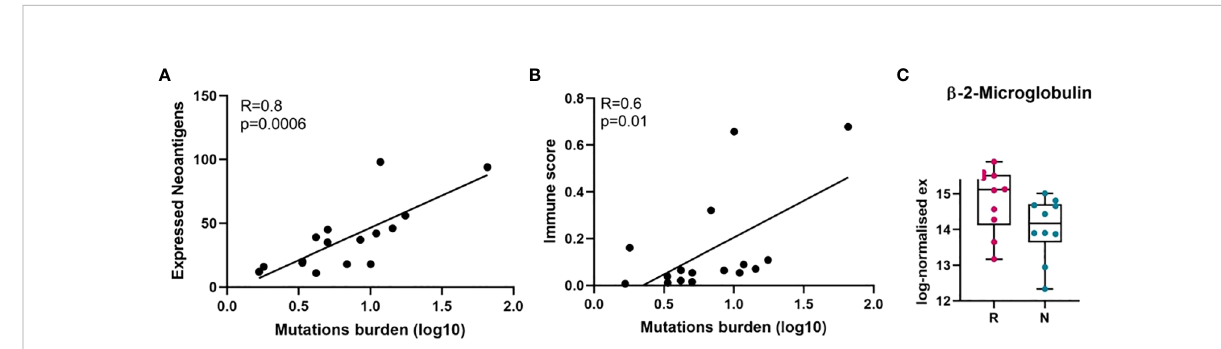
FIGURE 2 Correlation of mutation burden with neoantigens and immune score analysis. (A) Pearson correlation between tumour mutation burden and expressed neoantigens in melanomas. (B) Pearson correlation between tumour mutation burden and immune score in melanomas. (C) Beta-2- microglobulin ( B2M ) expression level in responder and non-responder tumours in log-normalised expression value (p = 0.06, not signi fi cant, Mann-Whitney U). Here, because RNA-Seq was performed on twenty samples, it was only possible to match twenty samples from TMB and RNA-Seq data (responder = 10, non-responder = 10) were used to perform Pearson correlation analysis. On the horizontal axis in C), R, responder; N,